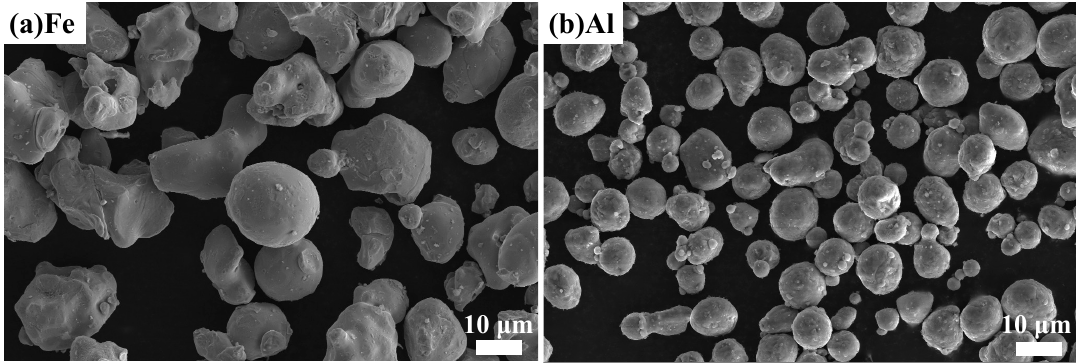
Figure 1. SEM images of feedstock powders: ( a ) Fe and ( b ) Al powders. Different ratios of Al powders—25 wt.%, 50 wt.% and 75 wt.%—were mechanically mixed with Fe powders in a V-type mixer for 15 h. The mixed Fe/Al powders were preheated by a propelling gas at 350 ◦ C and deposited by a TECHNY LP-TCY-III supersonic cold spraying system onto the substrates. The converging–diverging nozzle of the gun had a throat diameter of 6 mm. The atmosphere gas worked as the propelling and